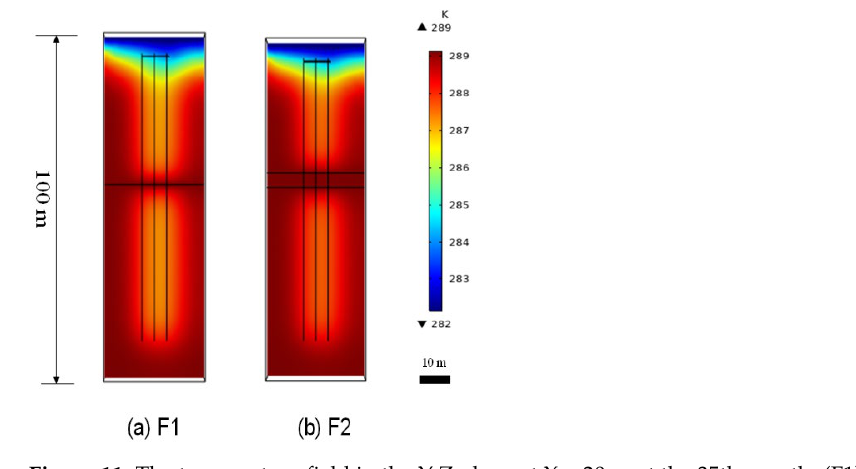
Figure 11. The temperature field in the Y-Z plane at X = 20 m at the 35th month: (F1) one horizontal fracture; (F2) two horizontal fractures.